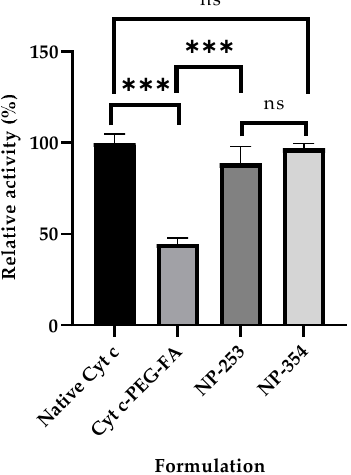
Figure 3. Caspase activity of surface-decorated nanoparticles (NPs) and NP-free formulation using a cell-free assay. The relative caspase activities for NP-253 and NP-354 surface-decorated NPs were not significantly different between them or when compared to the native Cyt c (ns compared to both NPs). The NP-free formulation, Cyt c-PEG-FA, showed decreased caspase activity compared to both NP-253 and NP-354 (*** p < 0.001, n = 3 for each), and native Cyt c (*** p < 0.001, n = 3). Error bars represent the calculated standard deviations (SD). The names given to the nanoparticles, NP-253 and NP-354, refer to Cyt c-PLGA-PEG-FA NPs with diameters of 253 and 354 nm, respectively.